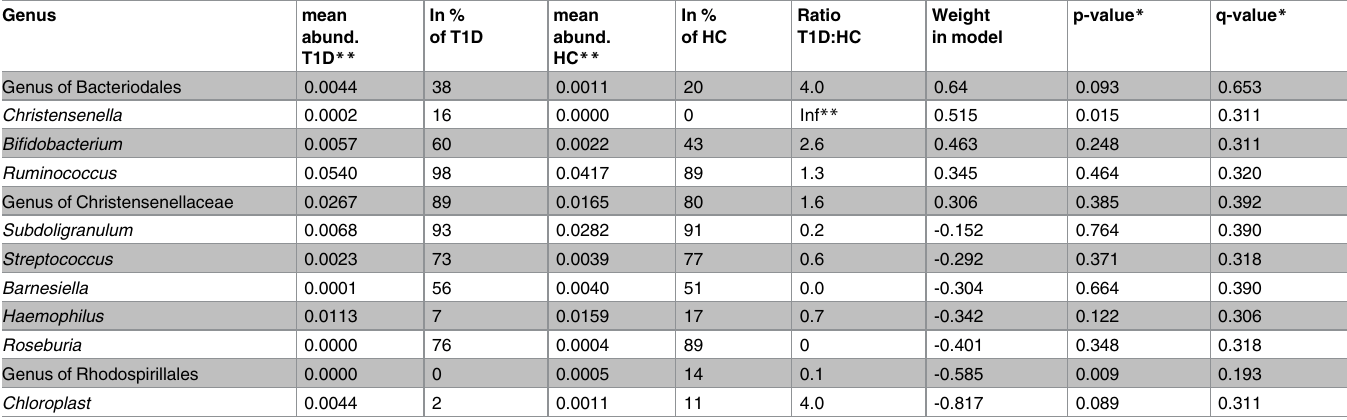
Table 2. Most discriminating fecal genera from elastic net analysis. Genus mean abund.